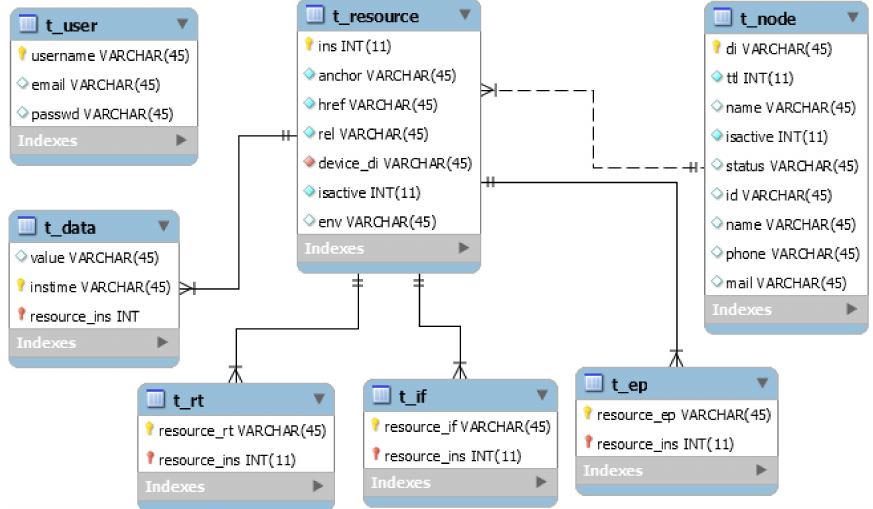
Figure 8. Entity–relationship diagram for the database in the IoT